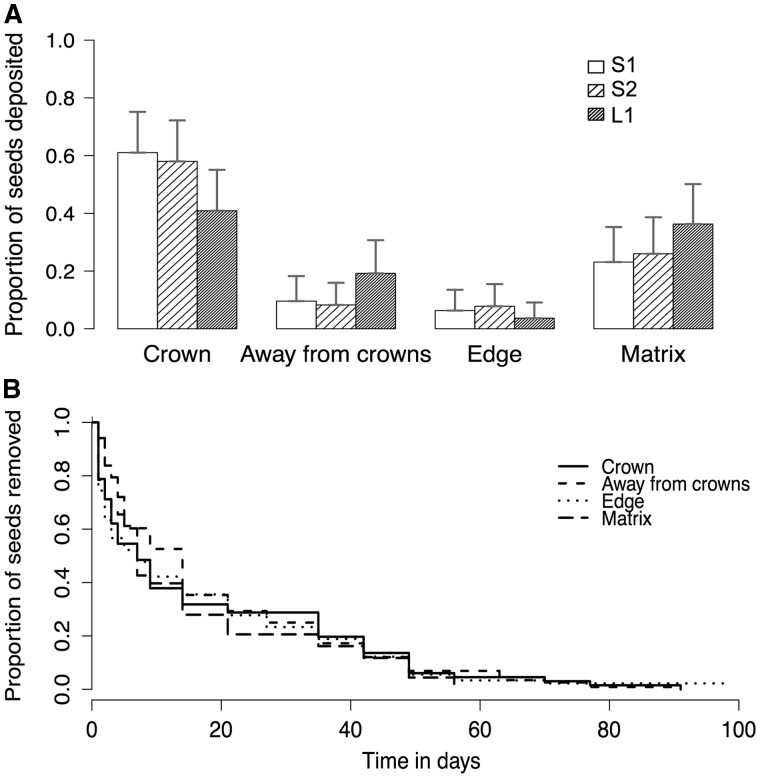
(A) Proportion of seeds dispersed by frugivores in the different microsites i.e. crown, away from conspecific crowns, edge of the swamp, and surrounding matrix in the three study swamps, S1, S2 and L1; bars represent mean (+SE) and (B) Secondary removal rates of dispersed (aril-removed) seeds from different microsites where seed deposition was observed.